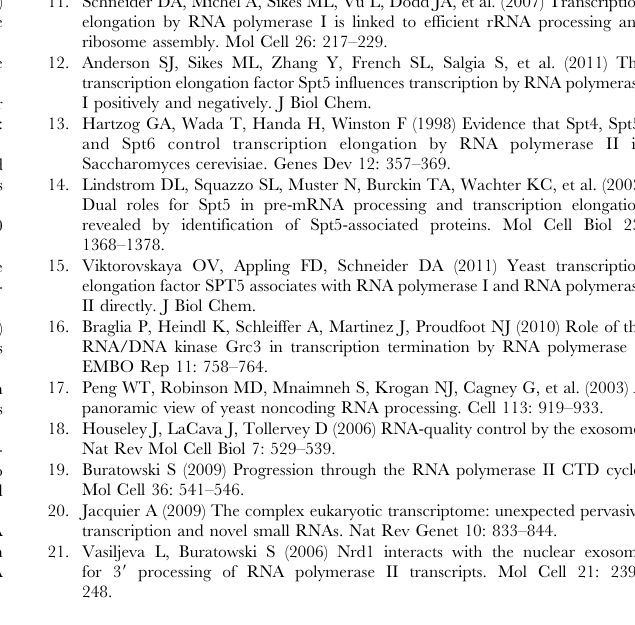
Figure S4 Quantitation of RNA ratio of Northern blots presented in Fig 5C. (TIF) Materials and Methods S1 Strains and oligonucleotides used in this